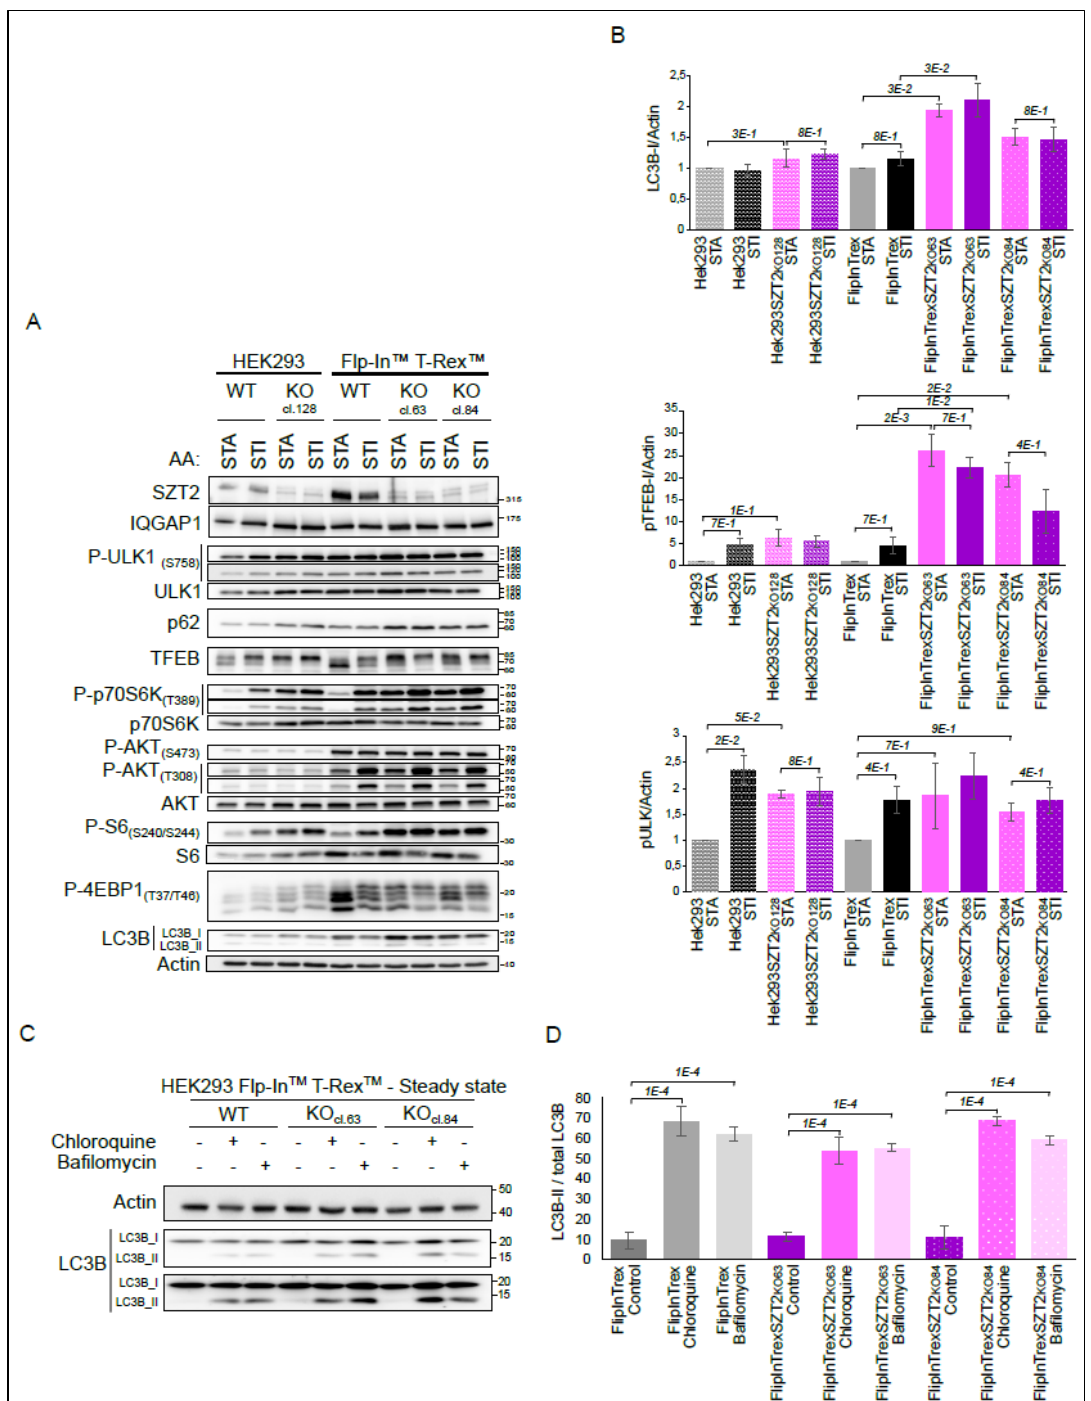
Figure 4. Characterization of the SZT2 KO cells under amino acids starvation and stimulation conditions. ( A ) Wild type and SZT2 KO cells were starved for amino acids for 1 h followed or not by restimulation for 20 min. The corresponding lysates were run on SDS-PAGE and analyzed by immunoblotting. SZT2 was detected on a separate membrane with IQGAP1 detection as a loading control. Data are representative of three independent experiments. ( B ) Relative quantification of the expression of selected proteins detected in A. Graphics display mean + SEM. ( C ) Wild type and SZT2 KO cells were treated with either Chloroquine or Bafilomycin for 6 h. Obtained lysates were run on SDS-PAGE and analyzed by immunoblotting. Data are representative of three independent experiments. ( D ) Relative quantification of expression of LC3B-II versus total LC3B. Graphics display mean + SEM.